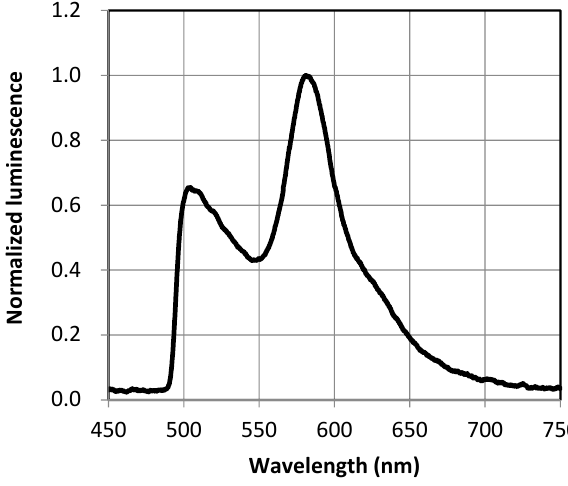
Figure 5. Emission spectra of two-color TSP consists of rhodamine B and fluorescein excited by a 405 nm laser.